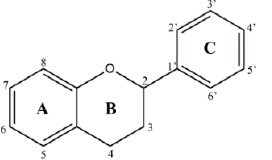
Figure 1. Chemical flavonoid core